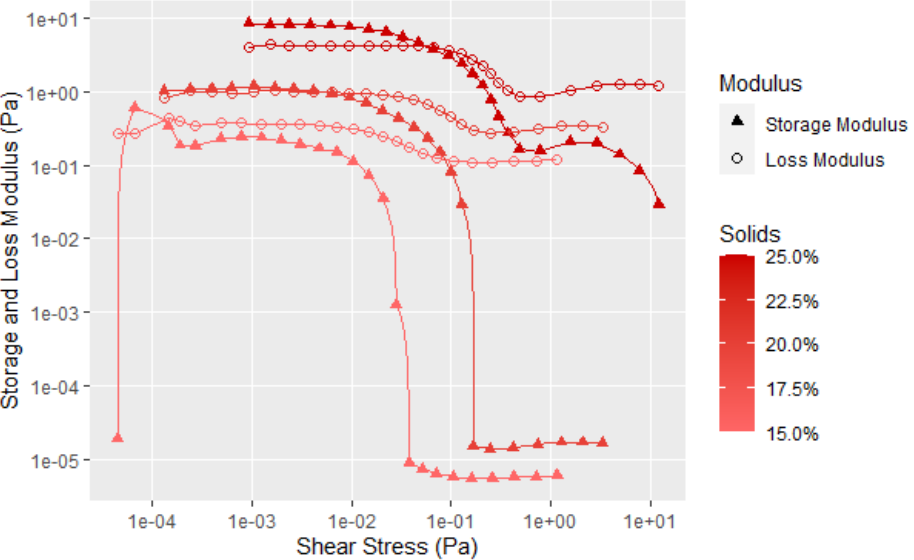
Figure 11. Amplitude sweep data for samples of 15, 20 and 25% 90 PDI flour with 60 min of mixing after the addition of SMBS. For the 15% sample the first data points are more variable under these operating conditions. Single test shown (not average). All replicates shown in A10.